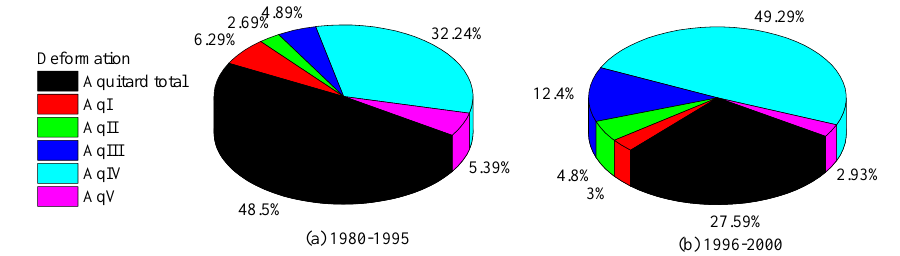
Figure 1. Pie chart of deformation of each aquifer in Shanghai (Data from Wei et al., 2010a).